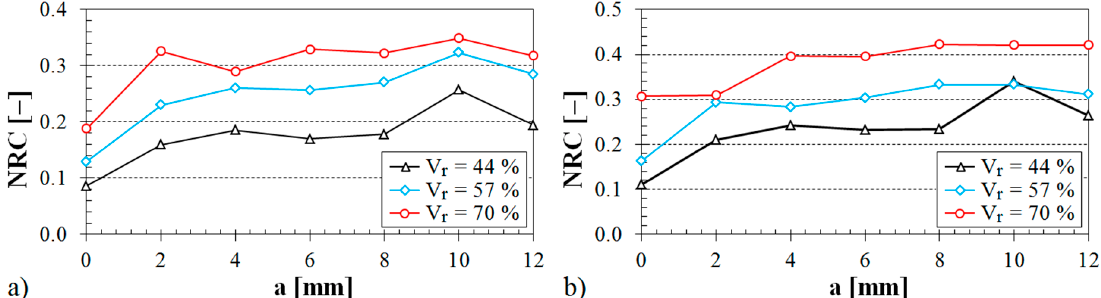
Figure 10. Influence of the volume ratio on the noise reduction coefficient vs. air space size for the tested ABS samples: ( a ) Rhomboid structure, sample thickness t = 2 cm; ( b ) Starlit structure, sample thickness t = 1 cm.